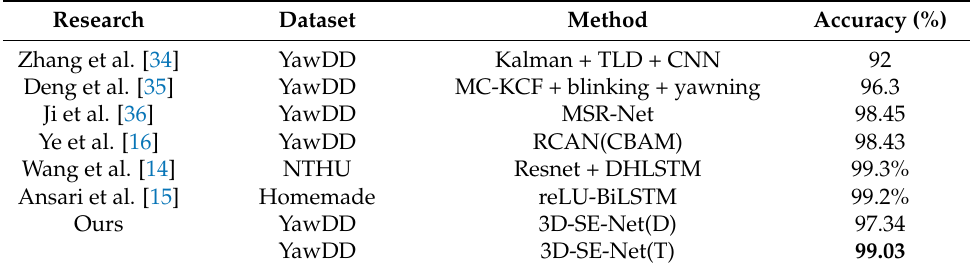
Table 3. Comparison results of the proposed method and state ‐ of ‐ the ‐ art methods.